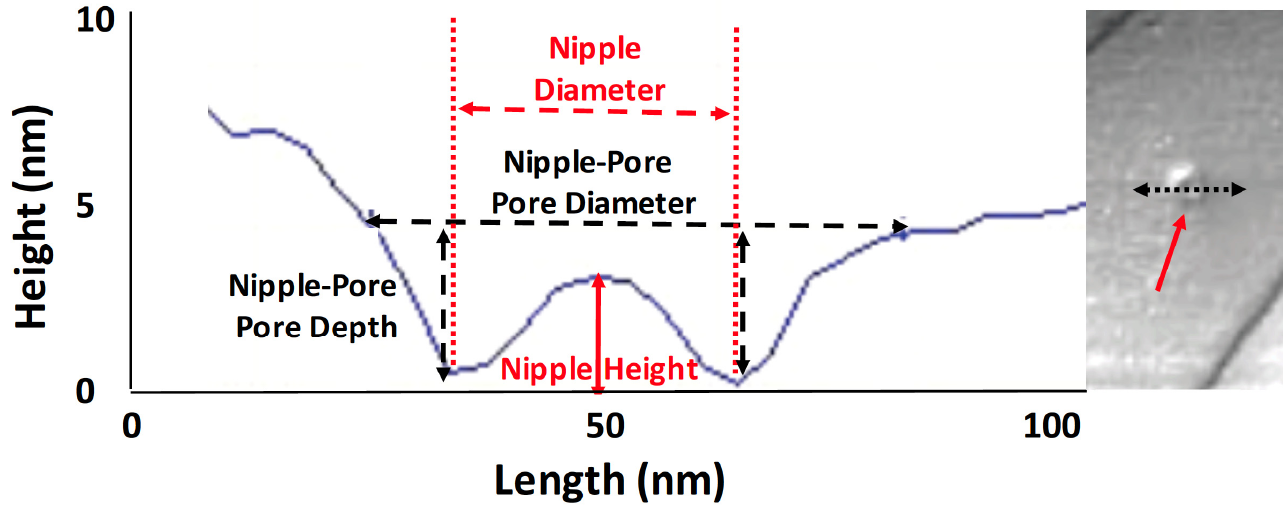
Figure 2. An AFM section taken through an Operophtera brumata nipple-pore using the Nanoscope Analysis “section” tool, illustrating how measurements were taken of pore diameter and depth, nipple diameter and height. Inset on the right shows the nipple pore (red arrow) that was measured, and the black double arrow shows the orientation of the section.